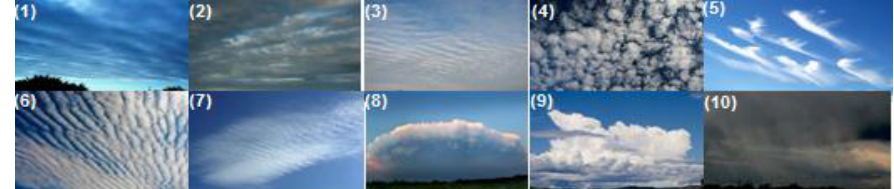
Fig.1: Represents the shapes of clouds as seen from ground, the sequence of images managed, as in the above explanation for the types of clouds